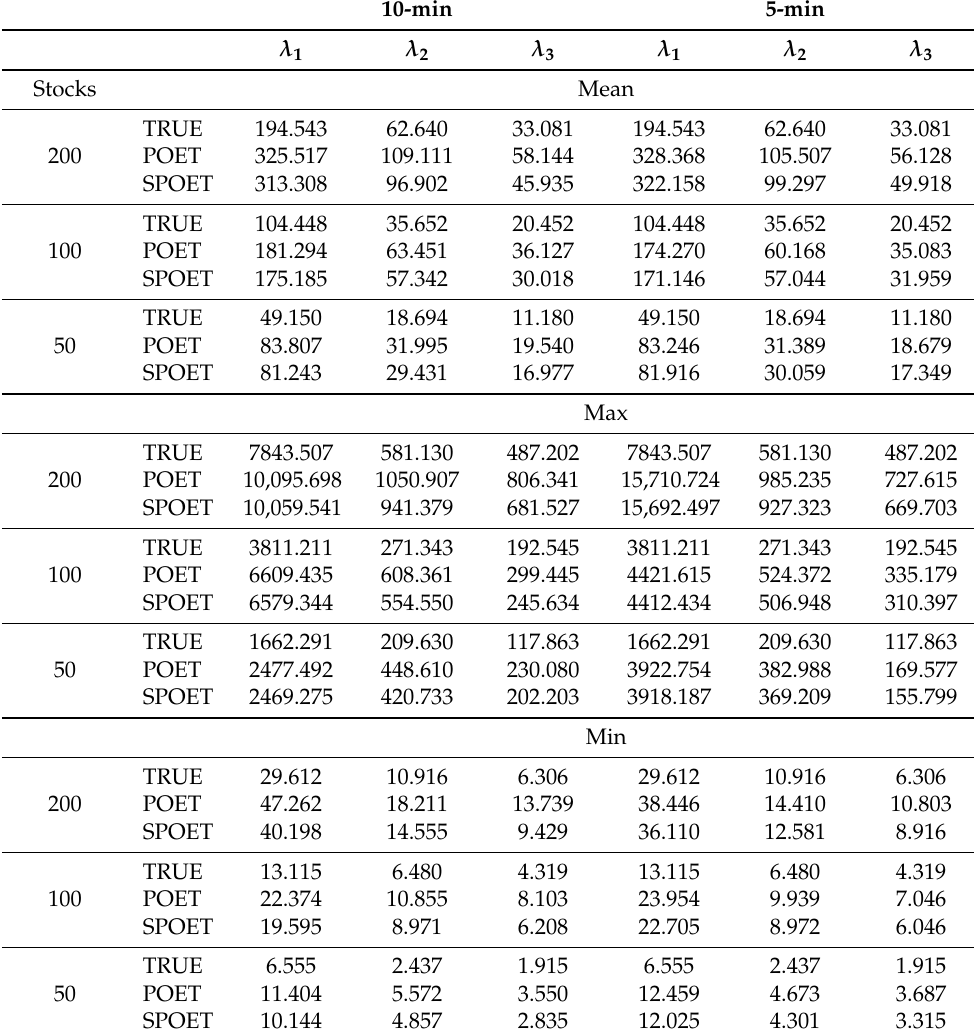
Table 1. Simulation results of